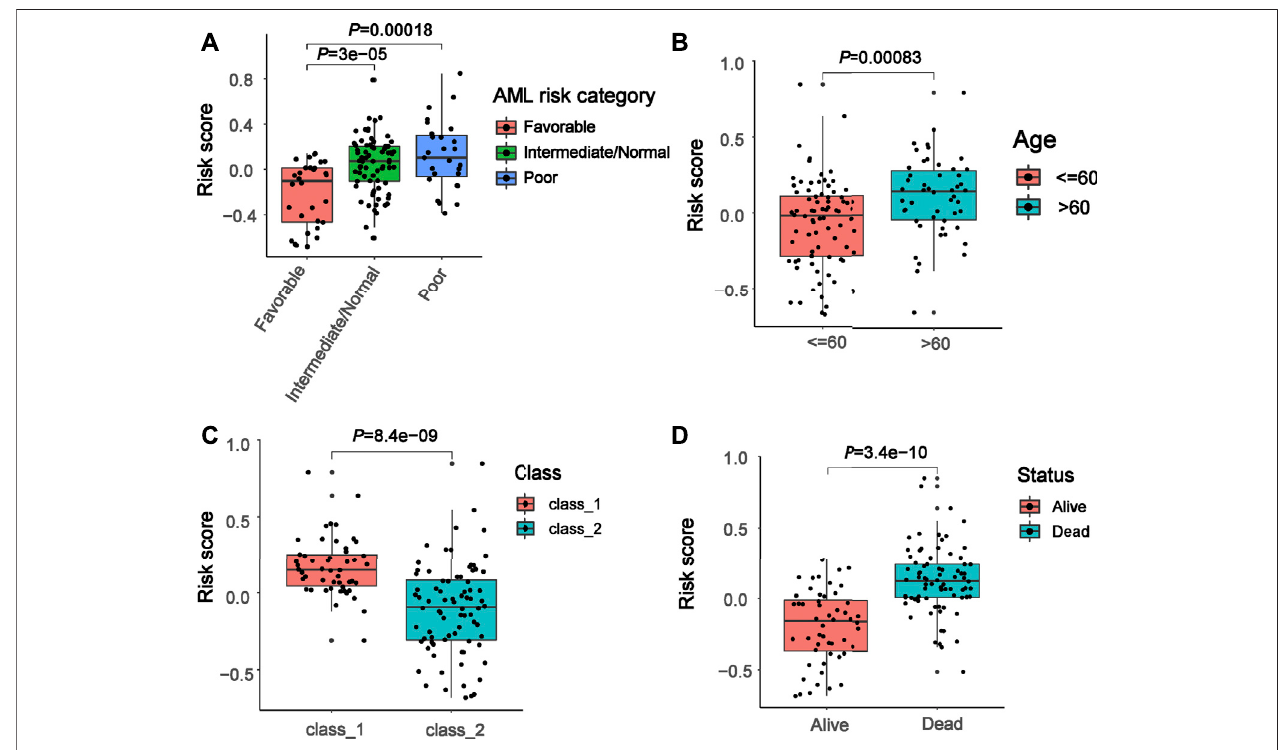
FIGURE 6 | Association between risk score and clinical features. (A – D) Correlation of the risk score with AML risk category, age, class, and status.